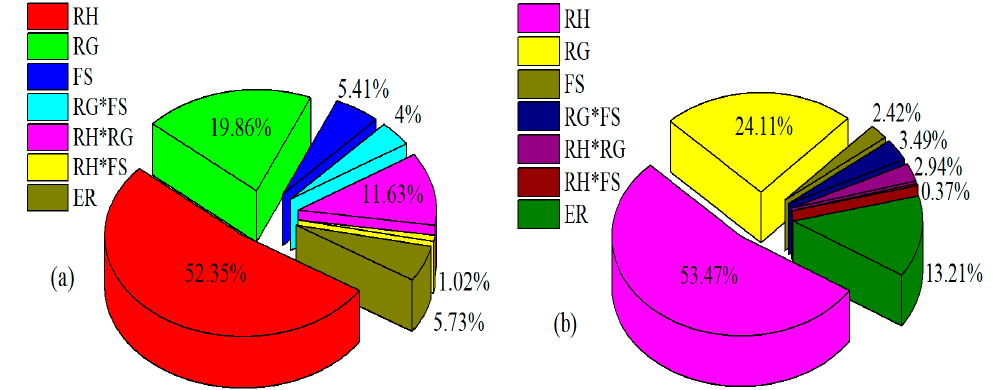
− –N loss ( a ) and PO 4+3 –P loss ( b ).